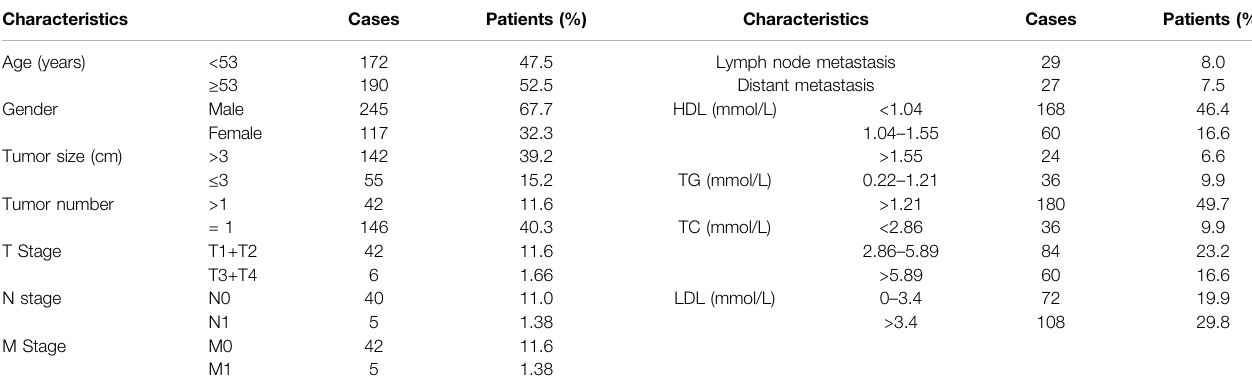
TABLE 1 | Clinicopathological characteristics of ccRCC patients.